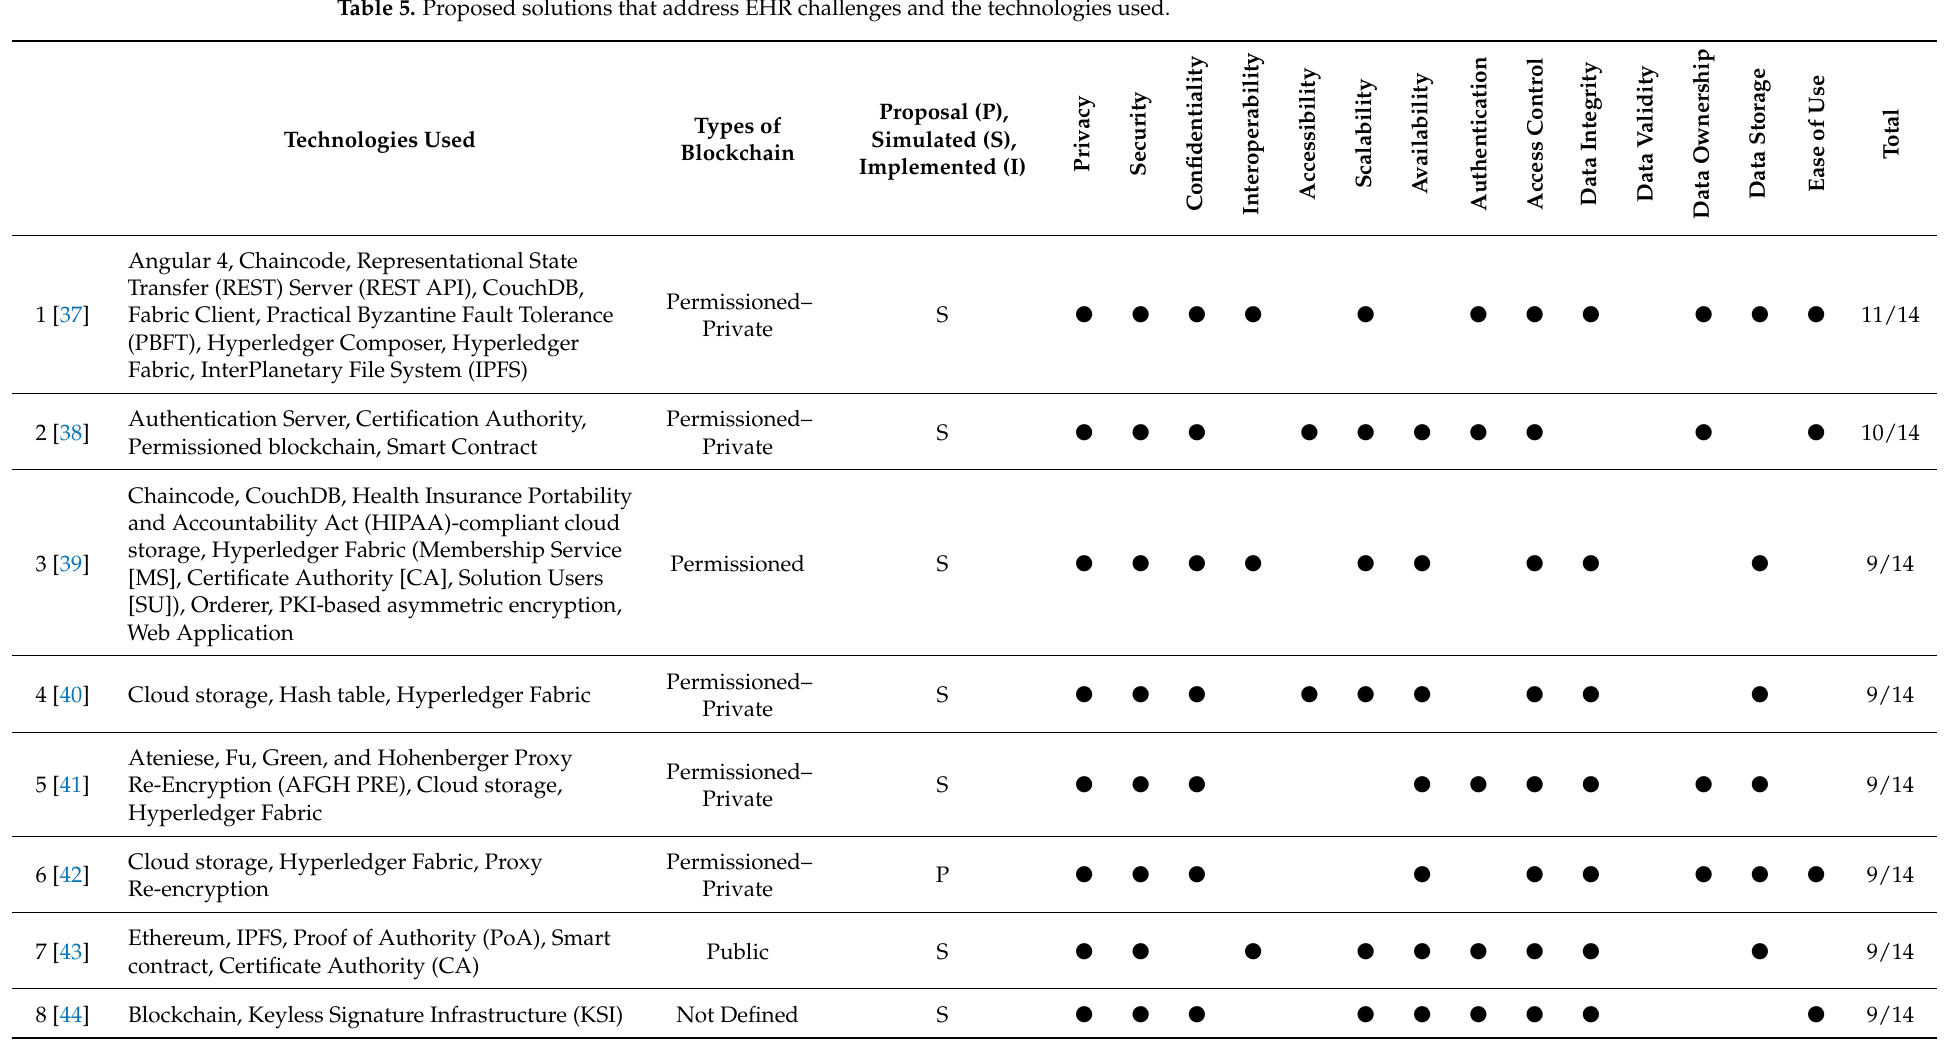
Table 5. Proposed solutions that address EHR challenges and the technologies used.